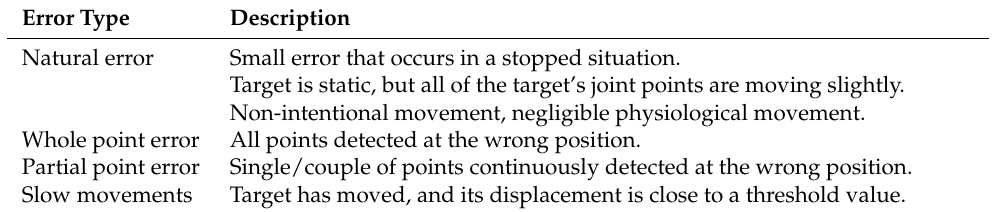
Table 1. Three limitations. Two limitations of the skeleton-based pose estimation model, another limitation in the movement detection system that uses the pose estimation model. Natural error and slow movement are closely